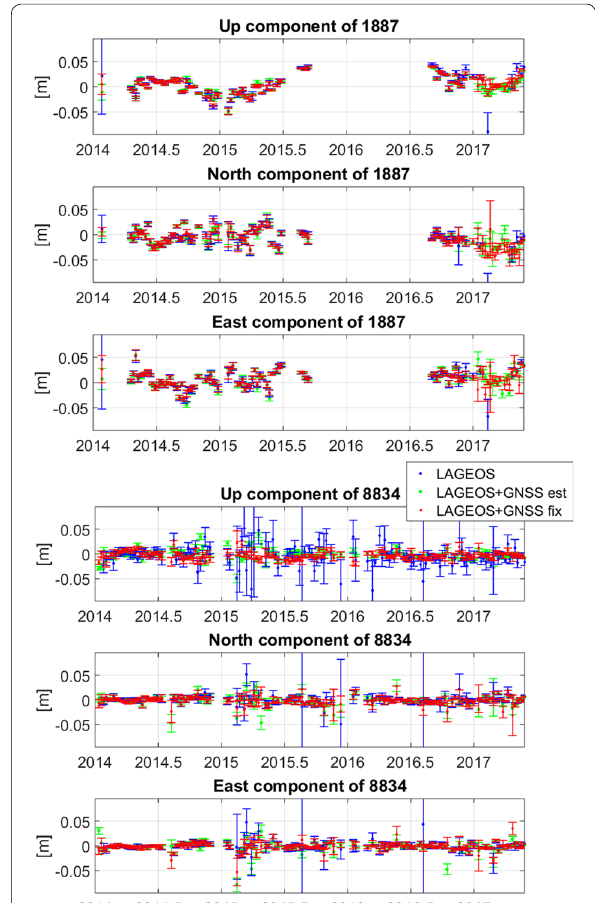
Fig. 7 The time series of station coordinates with respect to SLRF2014 for two example SLR stations: Baikonur (Kazakhstan, 1887) and Wettzell (Germany,